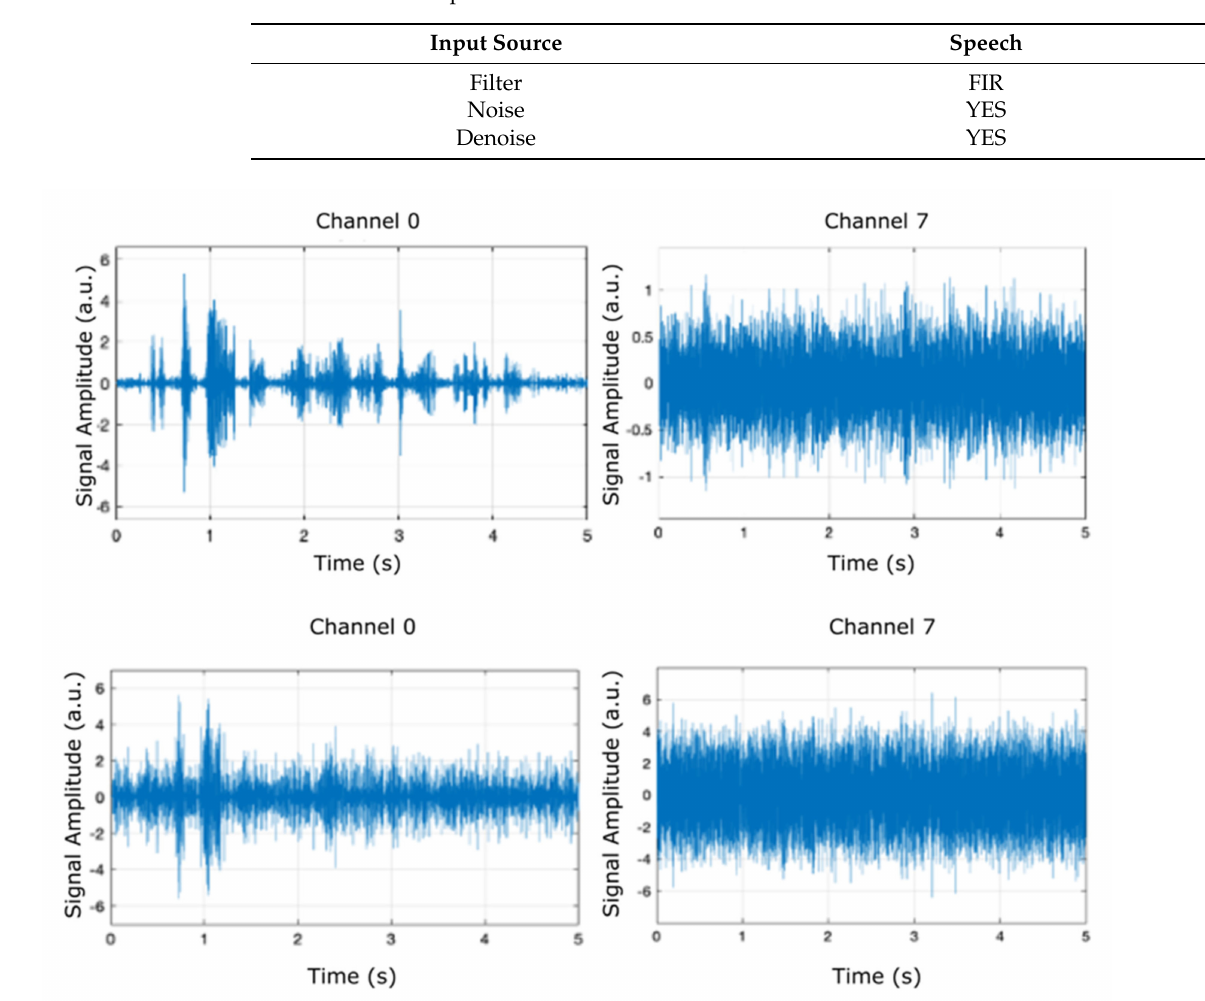
Figure 6. Results of electrical pulse generator for each two channels (channel 0 and channel 7) under the FIR filter, with Gaussian noise to the left, uniform noise applied to the right, and without the denoise block (scenario as in Table 3).